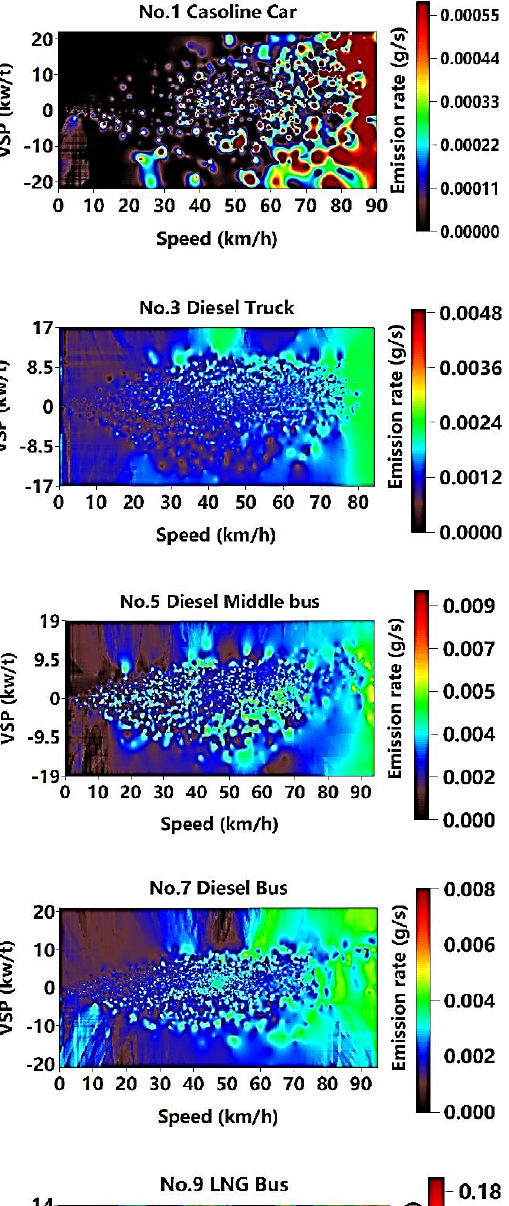
Figure 2. The image maps of the relationship between speed-VSP and CO emission rates. CO emission rates are represented by the colors. The black, brown, blue, cyan, green, yellow, orange, red, and ruby red areas indicate that the emission rates are approximately 0, 0.5, 1, 1.5, 2, 2.5, 3, 3.5, and over 4 times the average emission rate, respectively. Speed is at the X-axis, and VSP is at the Y-axis.